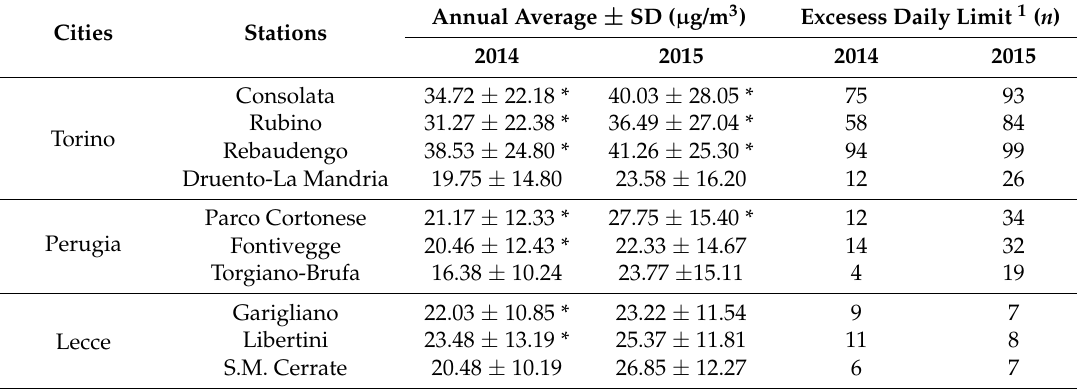
Table 2. Annual average ± standard deviation (SD) and number of exceedances of the daily limit value of PM 10 registered by monitoring station in the cities involved in the study.